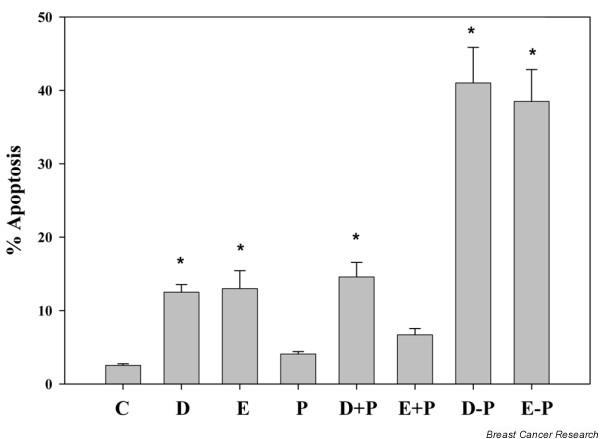
Effect of propofol-docosahexaenoic acid (propofol-DHA) and propofol-eicosapentaenoic acid (propofol-EPA) conjugates on breast cancer cell apoptosis. MDA-MB-231 cells (104) were incubated with 25 μM DHA (D), 25 μM EPA (E), 25 μM propofol (P), 25 μM each of D+P, 25 μM each of E+P, 25 μM propofol-DHA (D-P) or 25 μM propofol-EPA (E-P) for 24 hours. The control cells (C) were treated with equal amounts of ethanol. The apoptotic cells were stained by using the Vybrant Apoptosis assay kit as described in the text. Results are means ± SEM for four experiments. The results were analyzed by analysis of variance and Dunnett's multiple comparison test to control the Type I experimental wise error. Significant differences from the control (P < 0.05) are indicated with an asterisk.